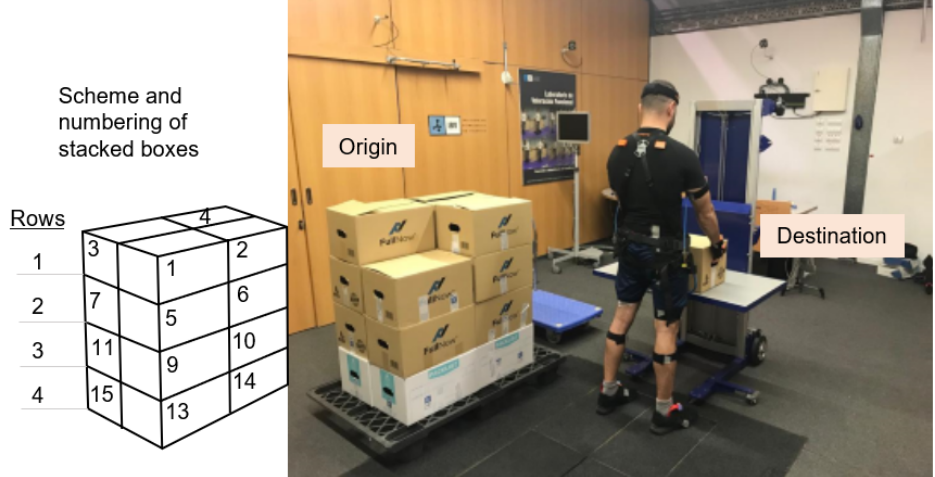
Figure 1. ( Right ): Picture of test set up. Structure of the pallet of 16 boxes and participant fully instrumented with exoskeleton, EMG sensors and MoCap inertial sensors. Origin: where boxes on pallet are picked up. Destination: table where user places boxes. ( Left ): Illustration of setup scheme. Numbers represent the order boxes are picked